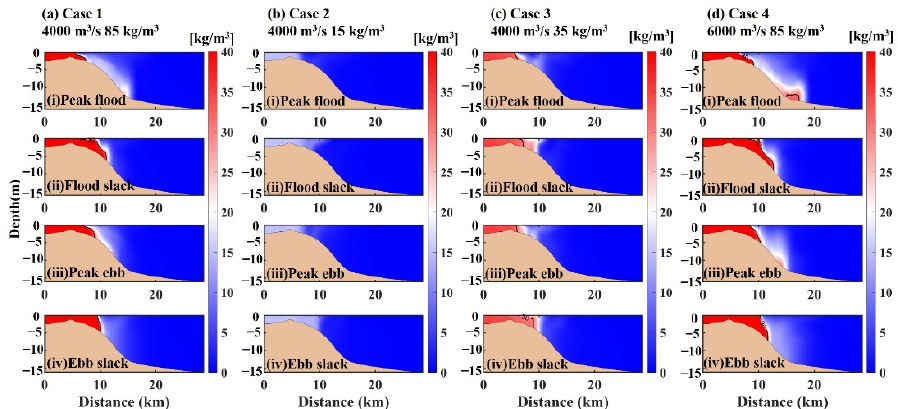
Figure 11. Vertical profiles of SSC along the axial section P1 at different times: Note that Figure 11a–d represent Case 1–4, respectively whereas ( i ) peak flood; ( ii ) flood slack; ( iii ) peak ebb; ( iv ) ebb slack.